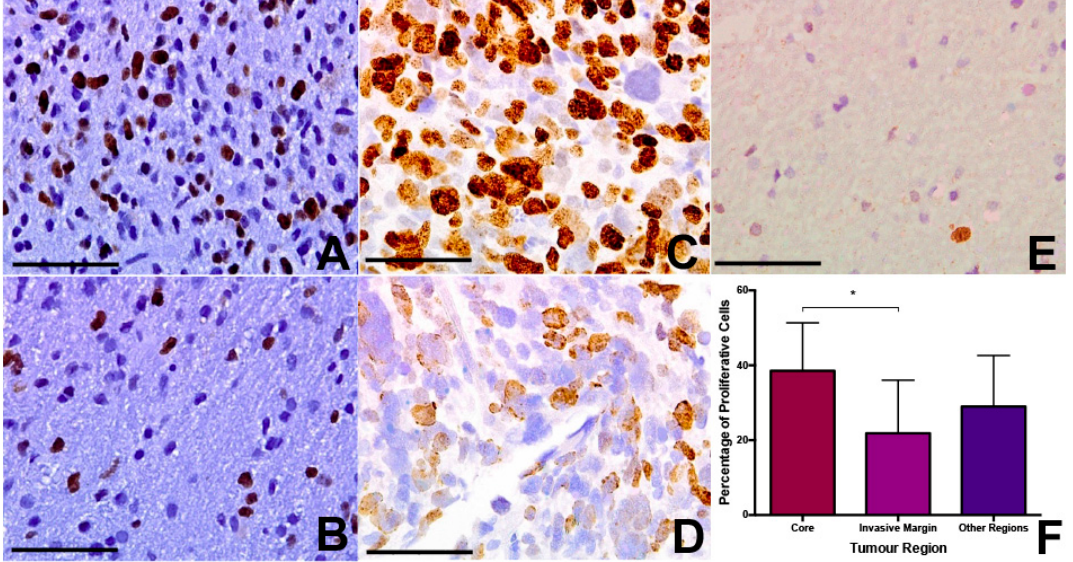
Figure 2. Intra-tumour proliferation index reveals lower growth rate at the GBM invasive margin. Using Ki67 immunohistochemistry we assessed the fraction of proliferating cells in each tumour region across the various samples. ( A , B ) Median Ki67 positive fraction was 39% for core samples (range 4–61%), ( C , D ) 26% for rim samples (range 2–45%) and ( E ) 22% for invasive margin samples (range 4–39%). On post-hoc t -test there was a significant difference between core and invasive samples (* p = 0.028) but not between rim and invasive or rim and core samples. ( F ) Number of cells positive on Ki67 immunohistochemistry in core, rim and invasive regions of GBM tumours. On post-hoc t -test, there was a significant difference between core and invasive samples, indicated by asterisk. ( A – E ) × 200. Error bars ( A – E ) 25 µm.